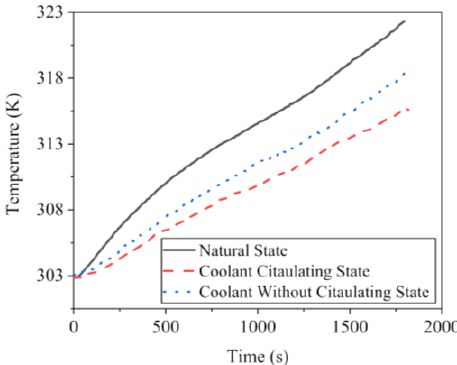
Figure 7. The temperature rises of the battery pack in different state.